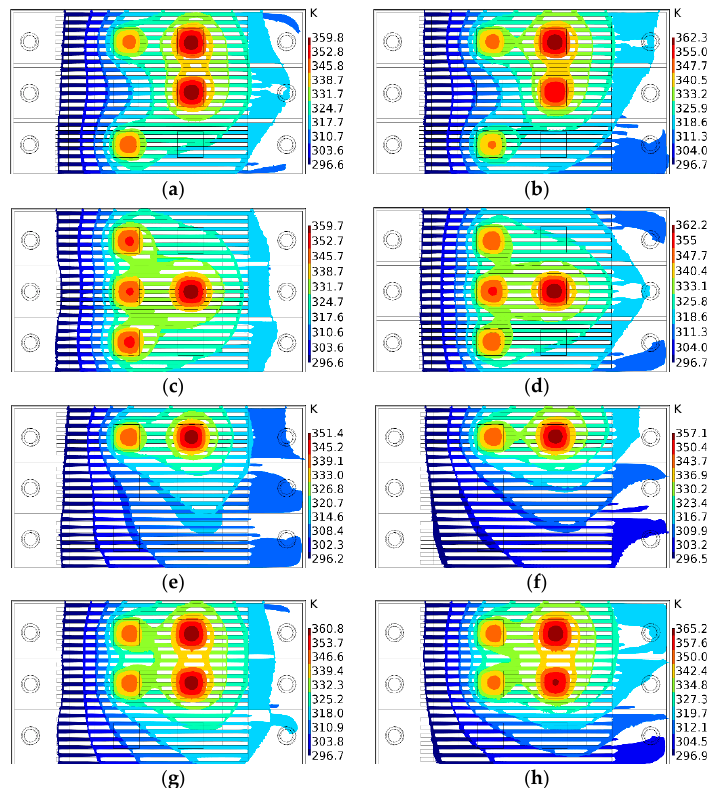
Figure 10. The isotherm diagrams corresponding to the chips before and after optimization. ( a ) Case 1 before optimization. ( b ) Case 1 after optimization. ( c ) Case 2 before optimization. ( d ) Case 2 after optimization. ( e ) Case 3 before optimization. ( f ) Case 3 after optimization. ( g ) Case 4 before optimi- zation. ( h ) Case 4 after optimization. Figure 11a,b show the temperature variation of the chip lateral nodes before and after flow optimization. The running chip core in the picture is marked with a red cross. It can